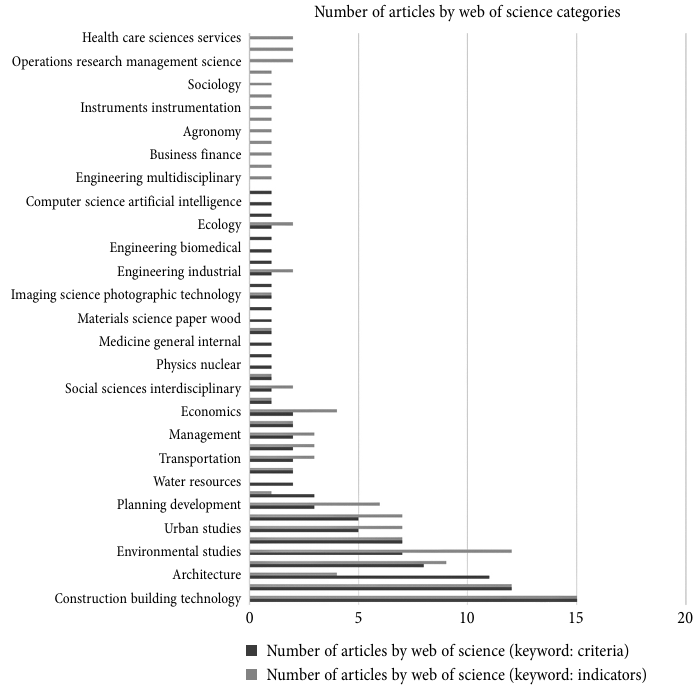
Fig. 5. Review of articles on criteria and indicators of the sustainable built environment by a research